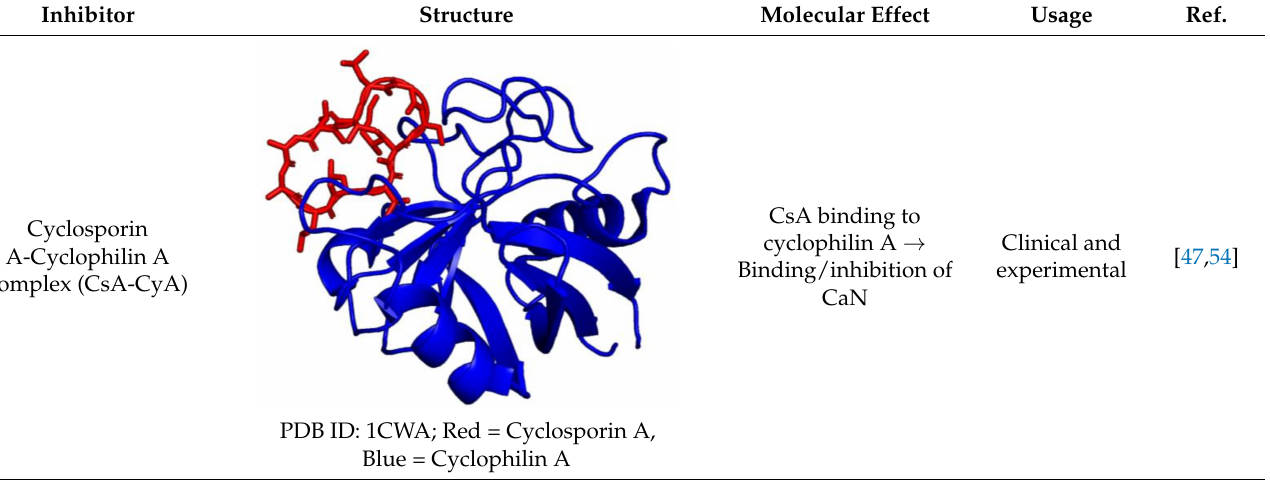
Table 1. Calcineurin inhibitors. Exogenous contributors to CaN inhibition shown in red, endogenous proteins that contribute to CaN inhibition shown in